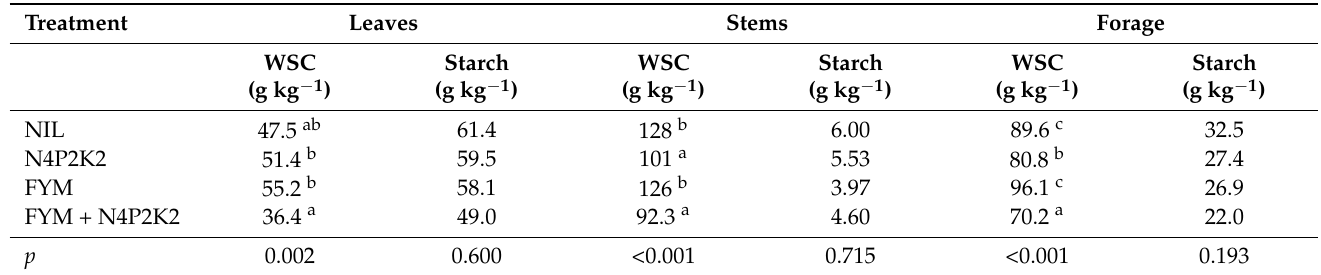
Table 2. Effect of fertilization treatments on water-soluble carbohydrates (WSC) and starch content in lucerne leaves, stems and whole forage in the first cut